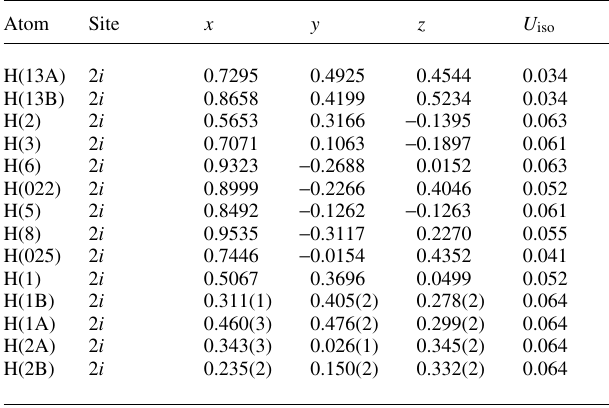
Table 2. Atomic coordinates and displacement parameters (in Å 2 )